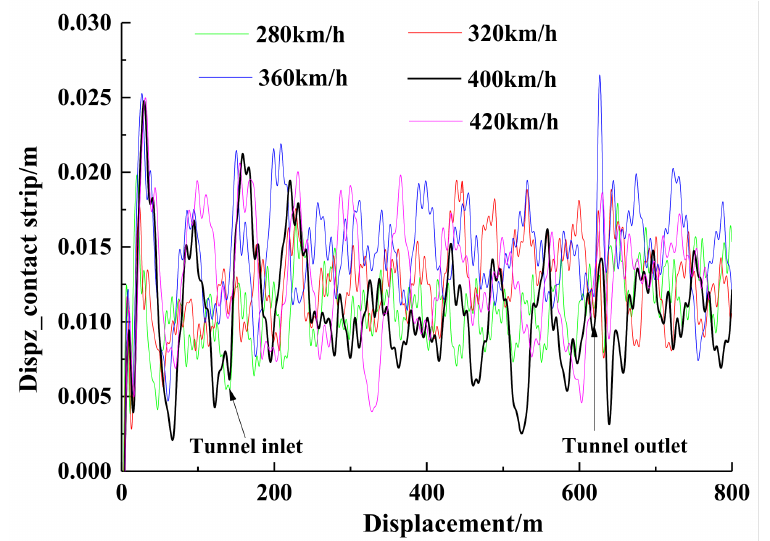
Figure 13. Comparison curves of vertical displacement of the contact strip passing through tunnel at different